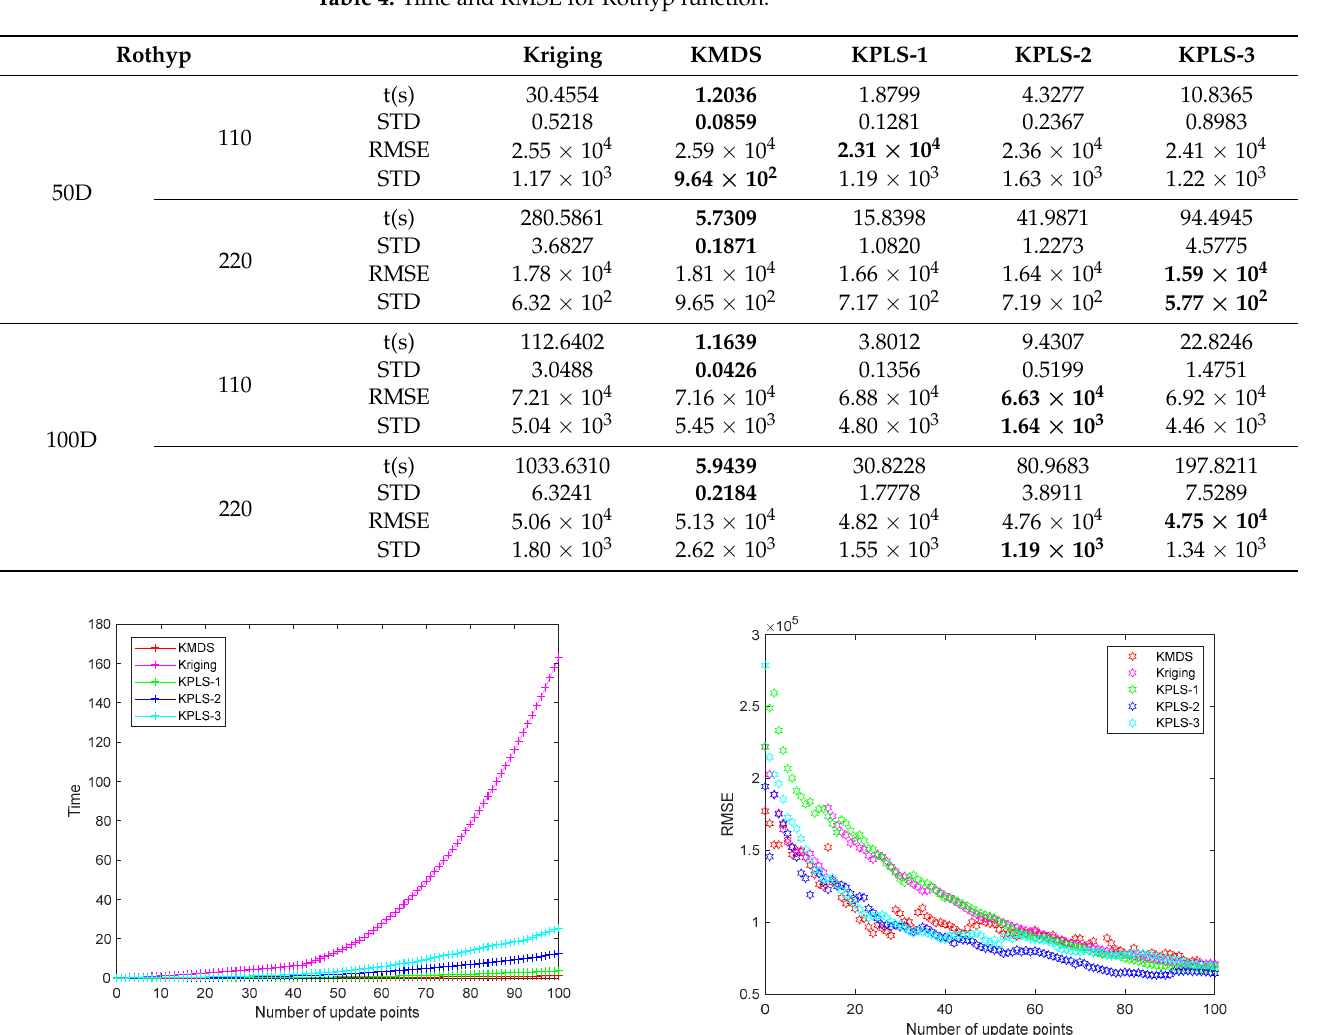
Table 4. Time and RMSE for Rothyp function.